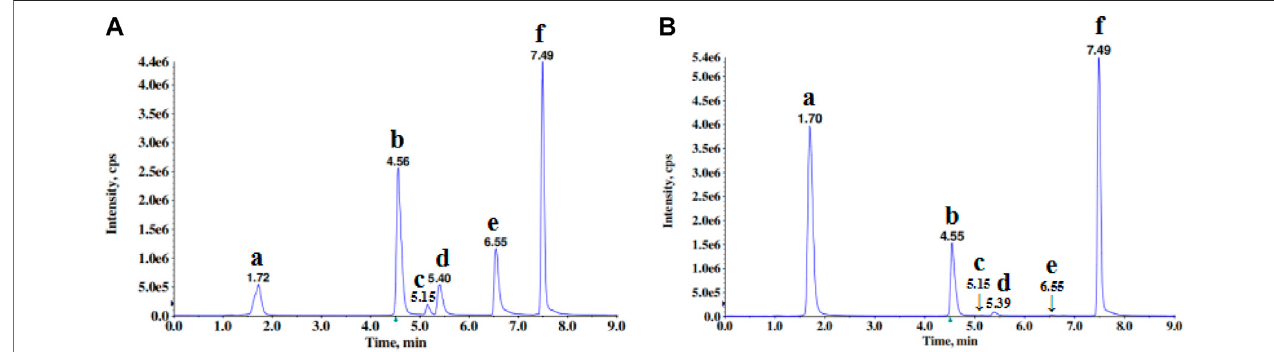
FIGURE1| TheTICsofthesixanalytesinmixedstandard (A) andsample (B) byUHPLC-MS/MSinpositiveandnegativeionmode.Alphabetscorrespondedtothe compounds as follows: a, gallic acid; b, ethyl gallate; c, quercitin; d, 7-O-galloyltriceti fl avan; e, quercetin; f, myricetin.